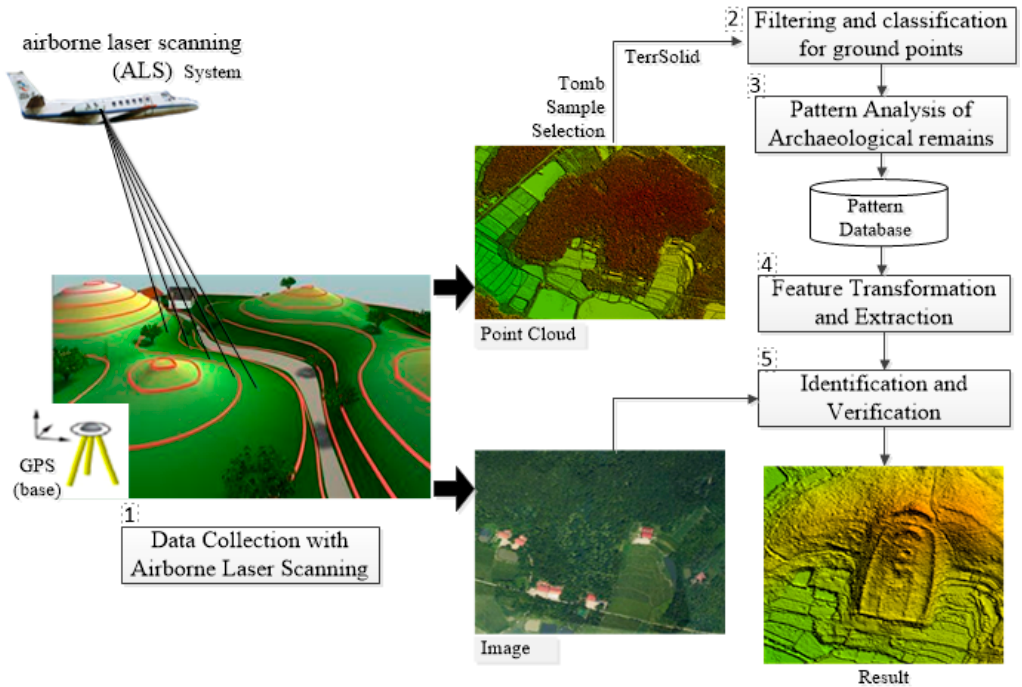
Figure 4. Framework of the proposed approach.